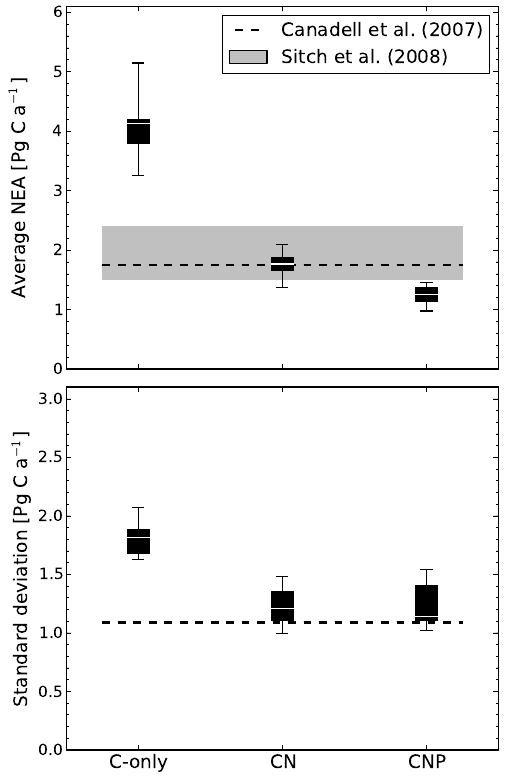
Fig. 3. Comparison of simulated NEA with previous studies. Box plots indicate the range in the mean NEA (upper panel) and stan- dard deviation (lower panel) simulated by all combinations of f W and f T in a specific nutrient limitation mode as indicated. Markers represent quartiles. Note data from Canadell et al. (2007) indicate range over the period 1959–2005 and data from Sitch et al. (2008) indicate range over the period